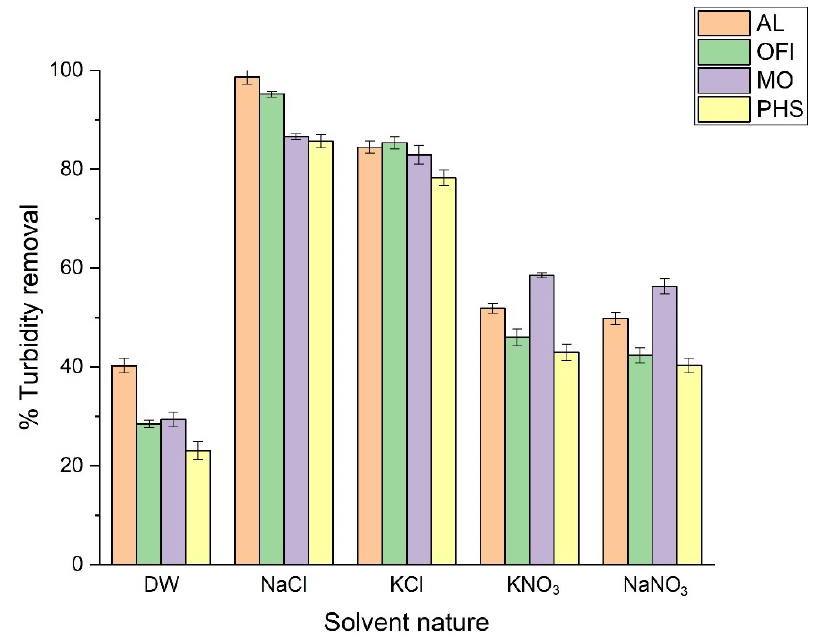
Figure 3. Effect of solvent nature on turbidity removal.